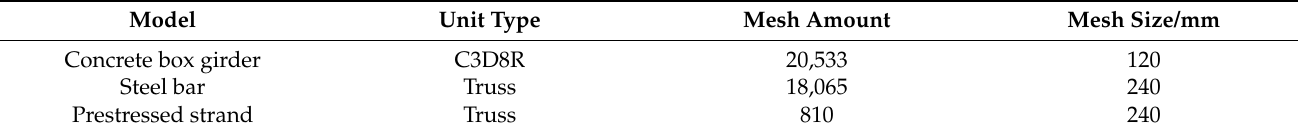
Table 5. Details of the finite element model.